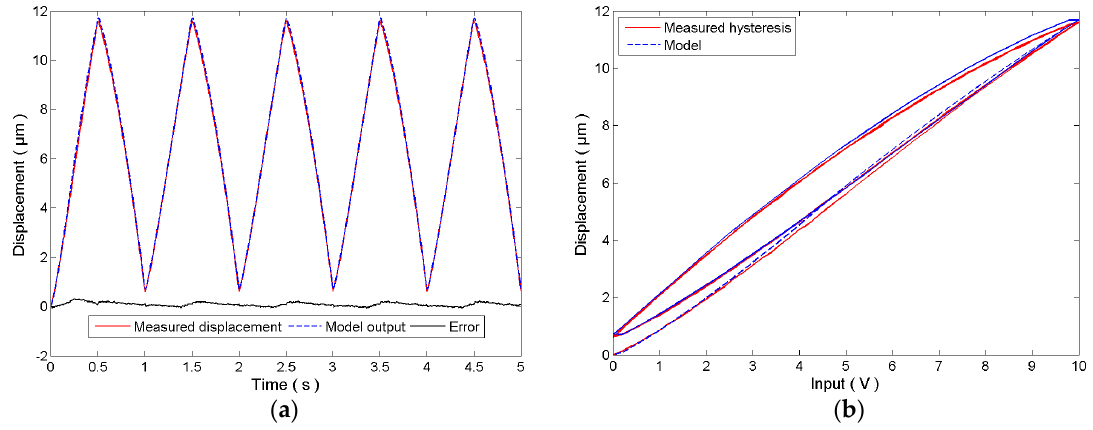
Figure 5. Verification of the rate-independent hysteresis model using another 1 Hz triangular signal: ( a ) time plot and ( b ) hysteresis plot.